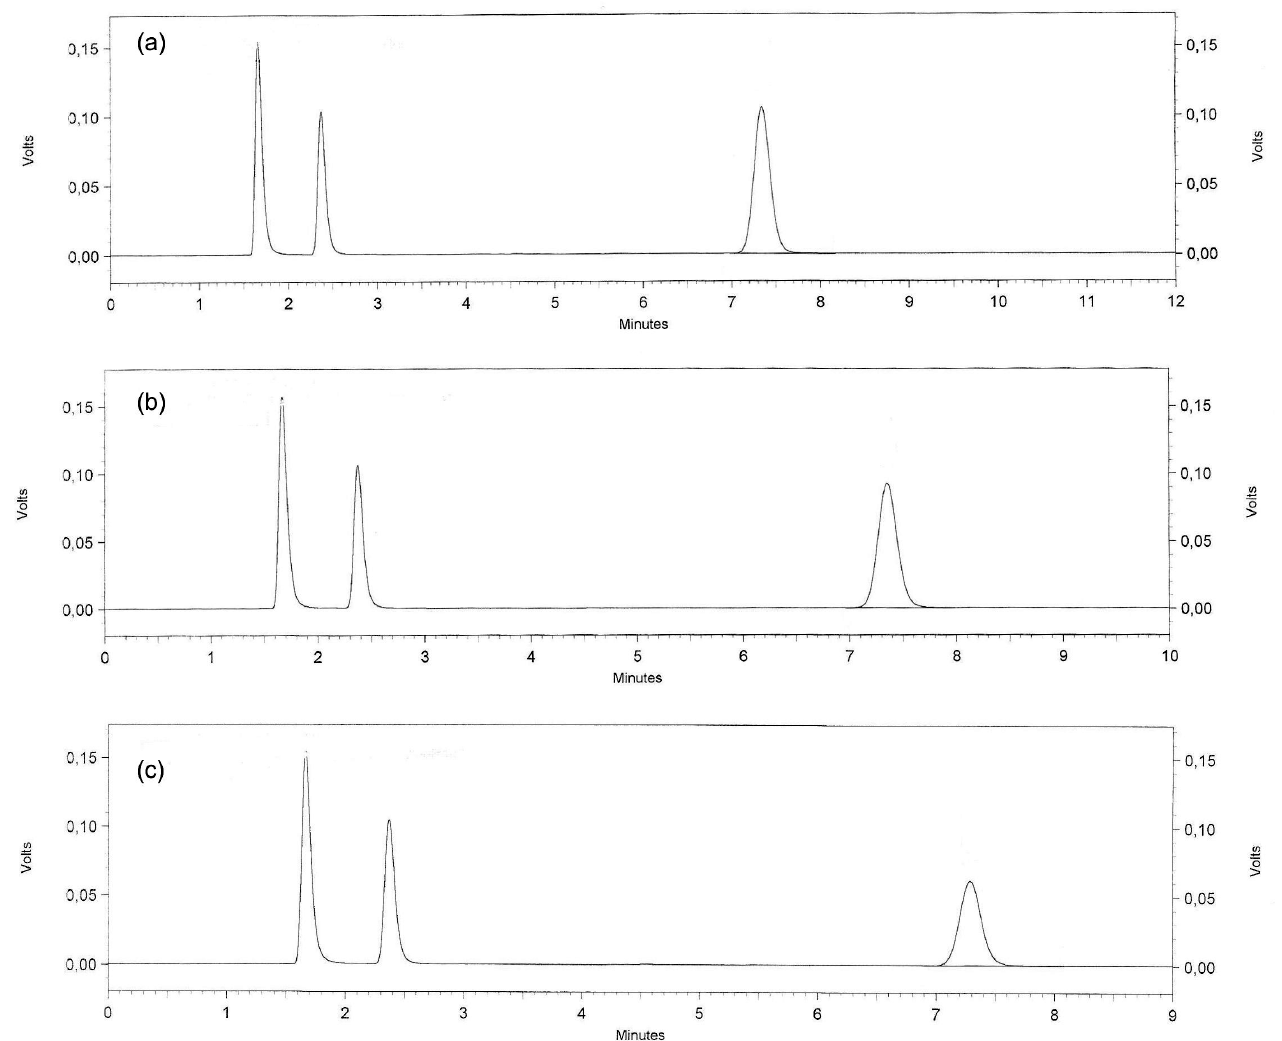
FIGURE 3 - Chromatograms corresponding to: (a) solution of DP reference substance time zero, (b) solution of DP reference substance time 5 hours and (c) solution of DP reference substance time 24 hours after oxidative